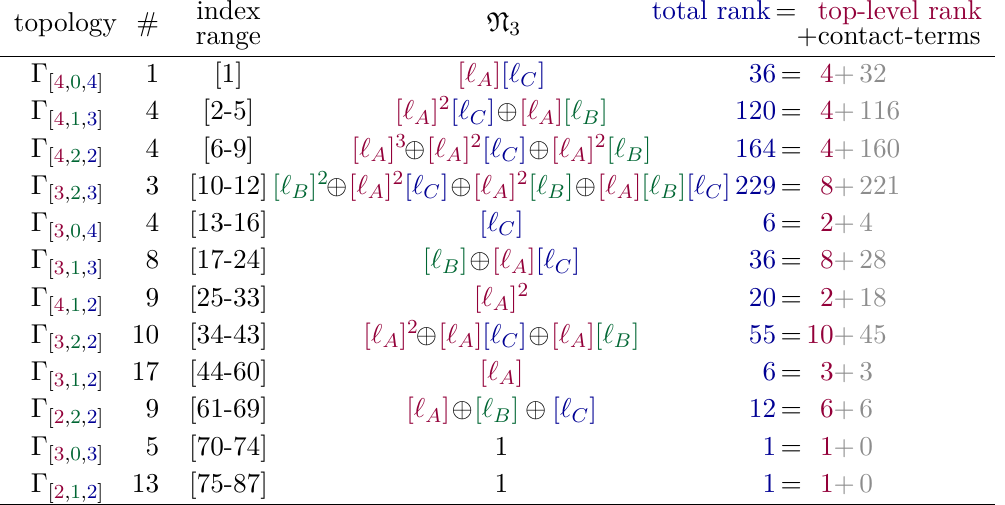
freedom will be fixed by these contours, together with their graph-isomorphic images as contact-term conditions according to